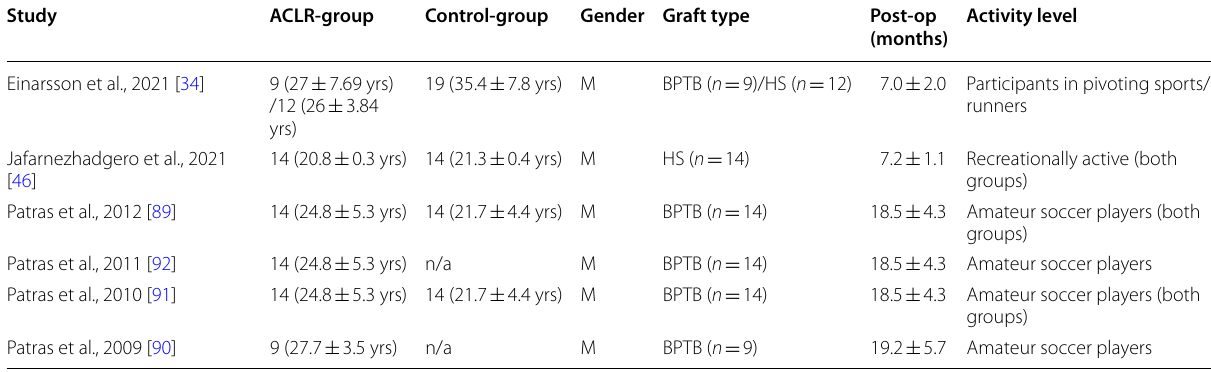
Number in brackets corresponds to reference number; sample size and age in years (mean M Male, BPTB Bone-patellar tendon-bone graft, HS Hamstrings graft, post-op time of testing since surgery in months (mean